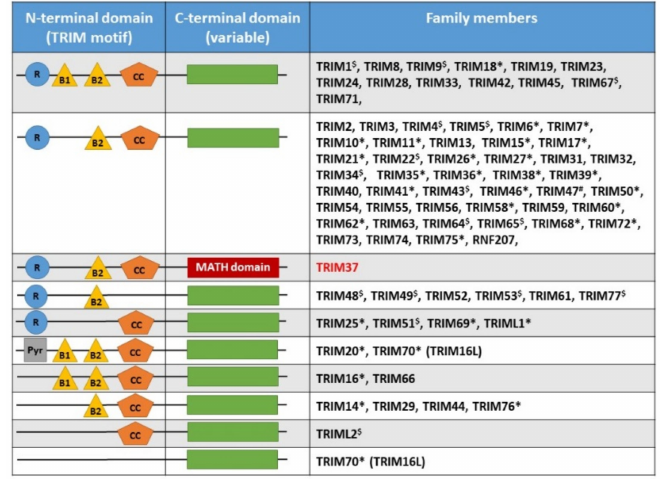
Figure 1. Comparison of the organization and classification of TRIM (TRIpartite motif) proteins.